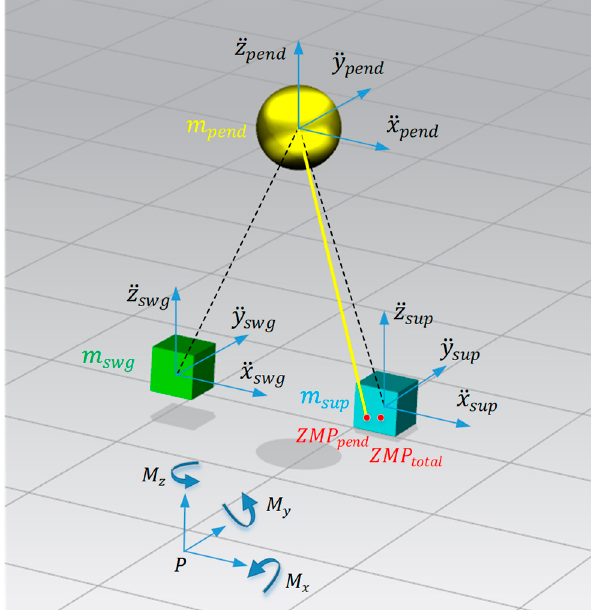
Figure 2. 3D three-mass model. The robot is divided into 3 parts: the inverted pendulum, the swing leg and the support leg. There is no kinematic constraint between the legs and the inverted pendulum. Z M P pend and Z M P total represent the zero-moment point (ZMP) of the inverted pendulum and the whole robot respectively. 𝑥,(cid:4663) 𝑦(cid:4663) 𝑎𝑛𝑑 𝑧(cid:4663) represent the accelerations of the center of mass in three directions, respectively.